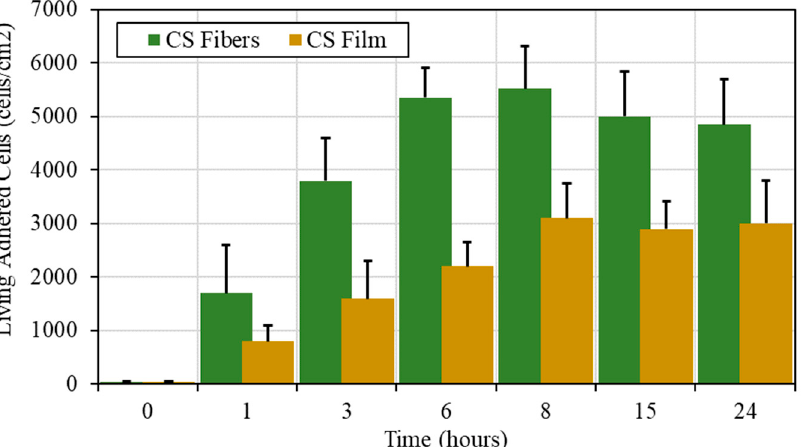
Figure 7. Cell adhesion kinetics of chondrocytes, presented as density of living cells as a function of seeding time, on chitosan fibers produced from CS/PEO blends using PEO MW = 5000 kg/mol compared to the adhesion response on CS film. Error bars represent mean ± SD ; n = 3.